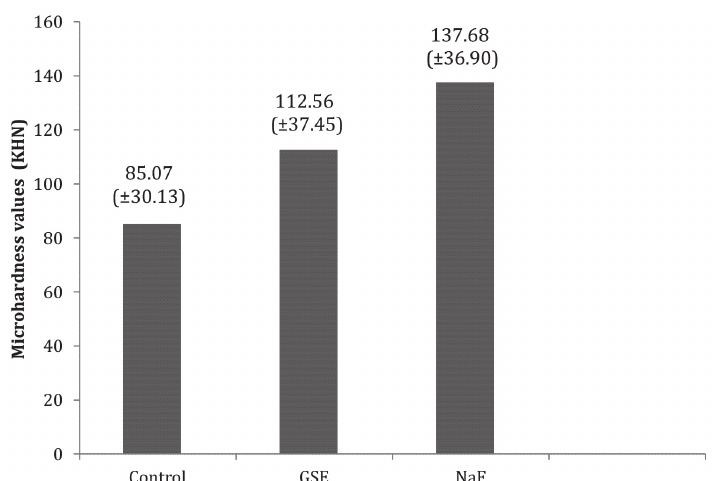
Figure 3- Means and standard deviation of enamel cross-sectional hardness (KHN) according to the different groups after